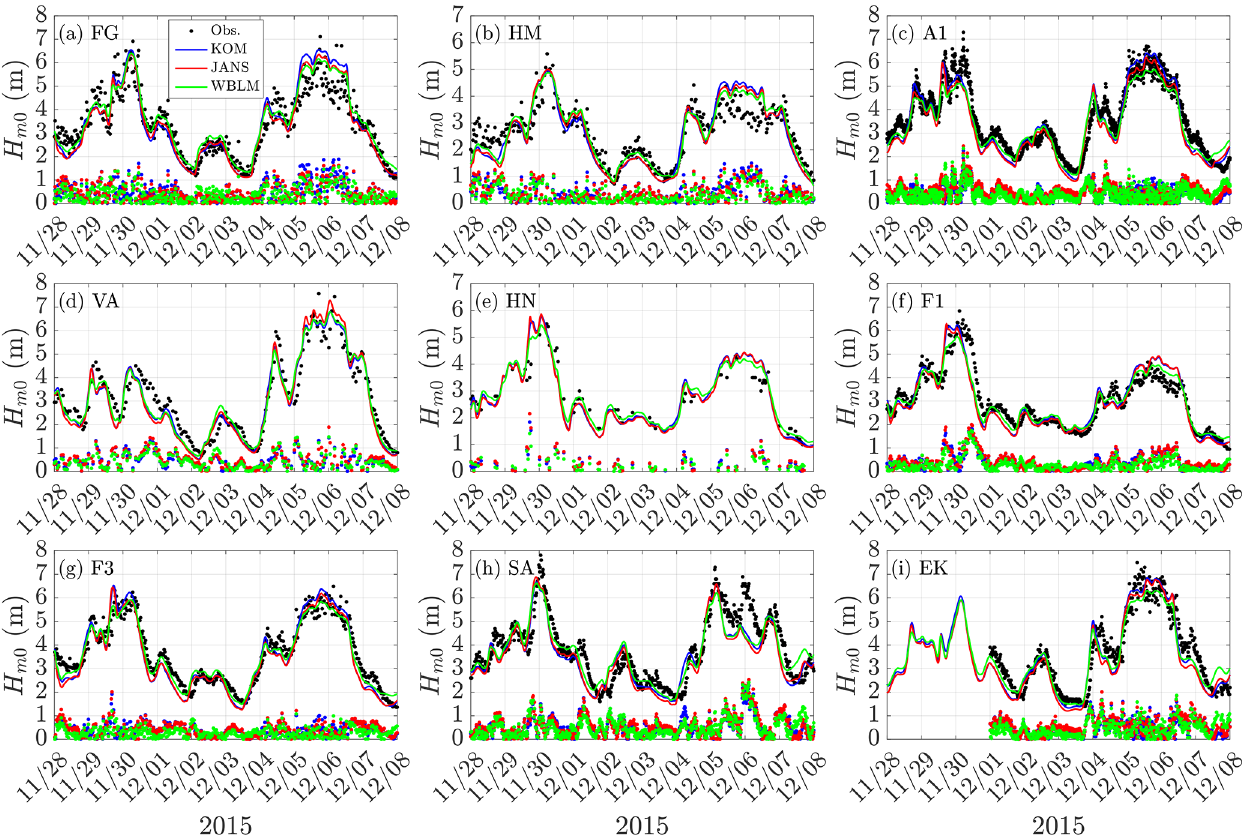
Figure 7. Time series of H m 0 at Fjaltring (FG), Hanstholm (HM), A121 (A1), Väderöarna (VA), Heligoland north (HN), Fino-1 (F1), Fino-3 (F3), Sleipner-A (SA), and Ekofisk (EK) during the two winter storms in the RUNE project. Observations are shown in black dots, modeled H m 0 using different source terms are shown in colored solid lines, and the corresponding colored dots show the absolute error between modeled results and observations.